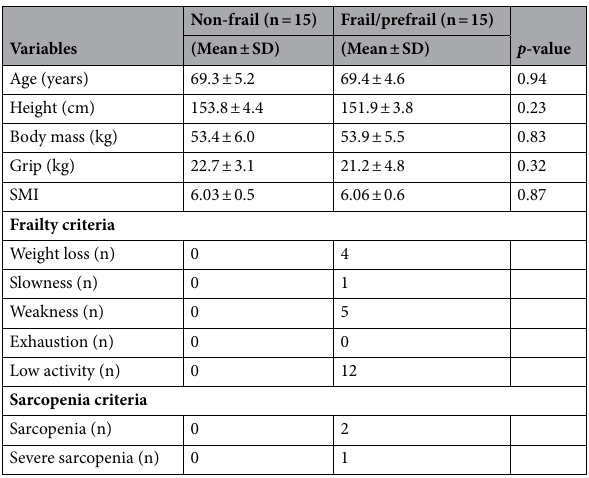
Table 1. Demographics of participants. SMI skeletal muscle mass